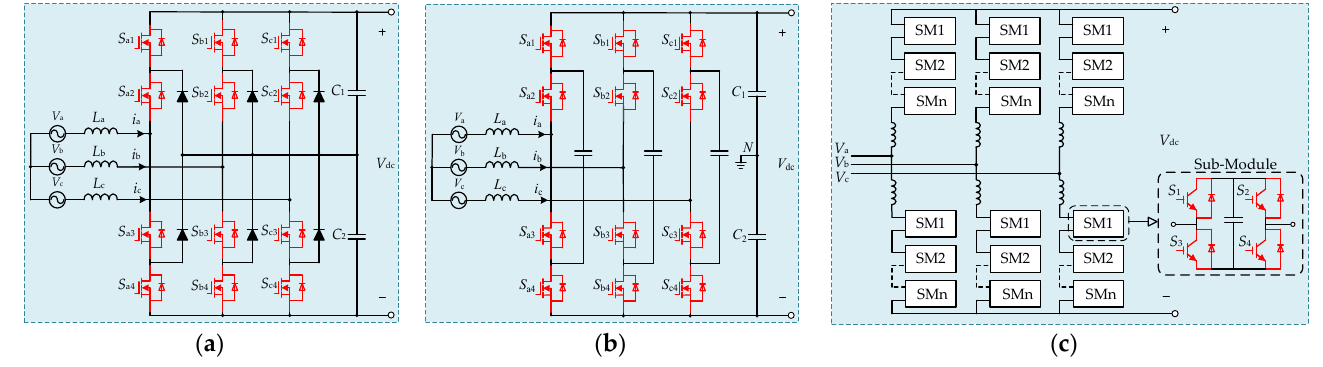
Figure 8. Multilevel converter topology. ( a ) Neutral-point-clamped three-level converter. ( b ) Flying capacitor three-level converter. ( c ) Cascaded H-bridge multilevel converter.